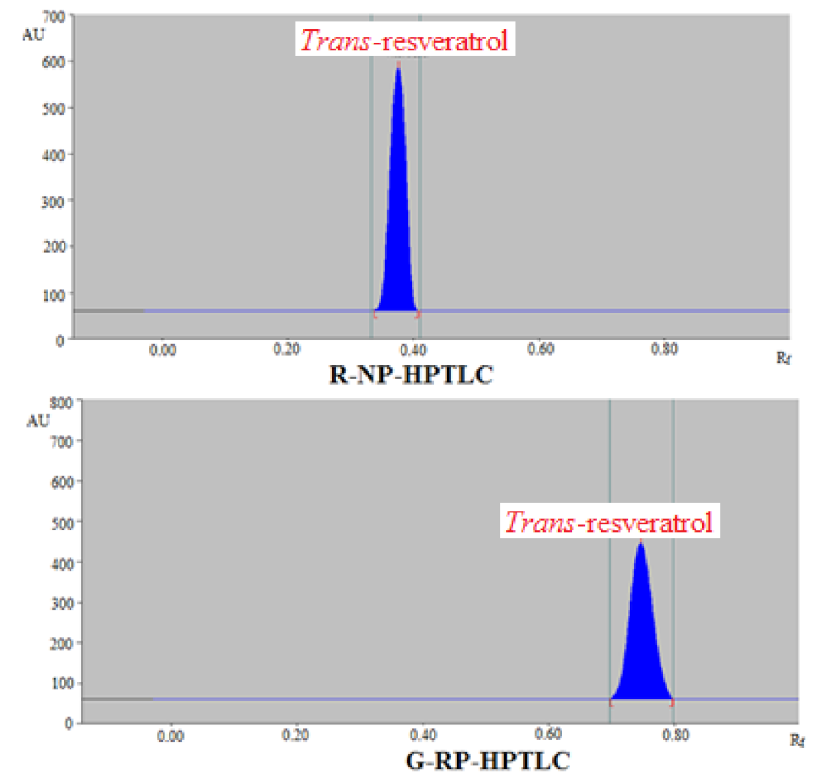
Figure 1. Representative densitometric chromatograms of standard trans -resveratrol (TRV) obtained using routine normal-phase high-performance thin-layer chromatography (R-NP-HPTLC) and eco- logically greener reversed-phase HPTLC (G-RP-HPTLC)